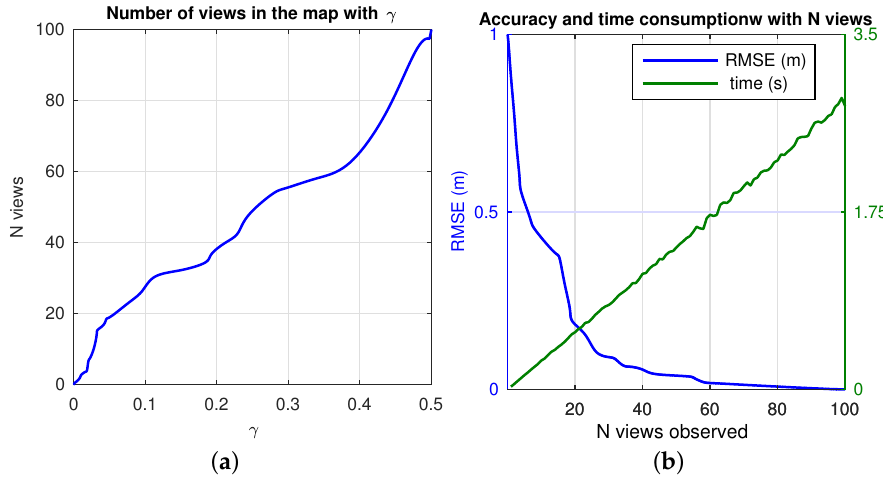
Figure 9. Effects of γ on the map estimation (mean values): ( a ) total number of views initiated in the map, N with γ ; ( b ) accuracy and time consumption with the number of views observed in the map.